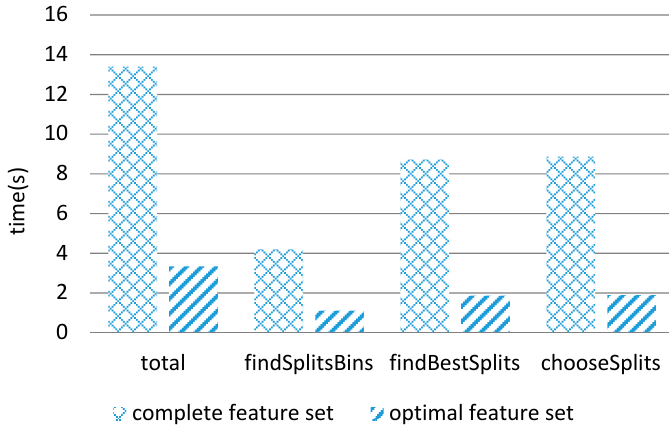
Figure 3. The comparison of the time for modeling and classification.